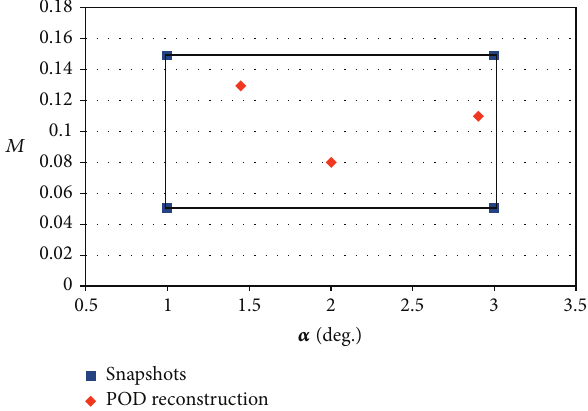
Figure 9: NACA 0012 airfoil. Snapshot positions and POD recon- struction points in the parameters space ( 𝑀 - 𝛼